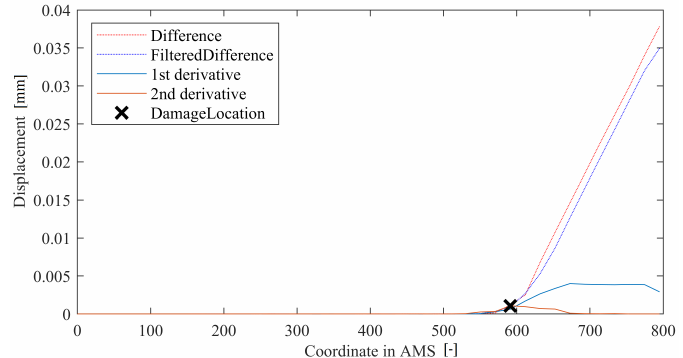
Figure 6. Example of operation of the SD method.